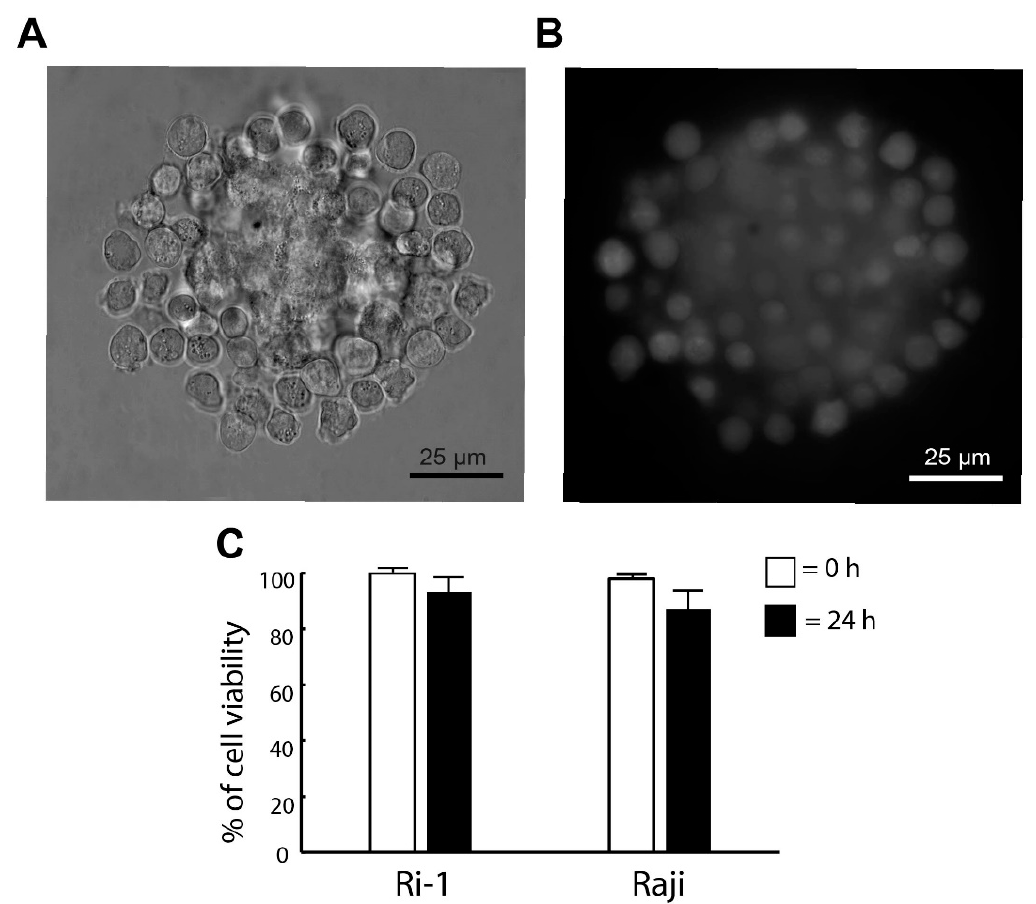
Figure 3. ( A ) De novo formed hybrid spheroid and ( B ) a fluorescent image of the spheroid stained with calcein (live cells) 24 h after the re-incubation. ( C ) Live/dead assay for the viability of the spheroid. Staining was performed immediately (0 h) and one day (24 h) after manipulations with calcein (live cells) and propidium iodide (dead cells). Quantification of the live/dead assay was performed using ImageJ software. An index of live lymphoma cells (% of cell viability) was constructed from the ratio of lived to the total cell numbers.